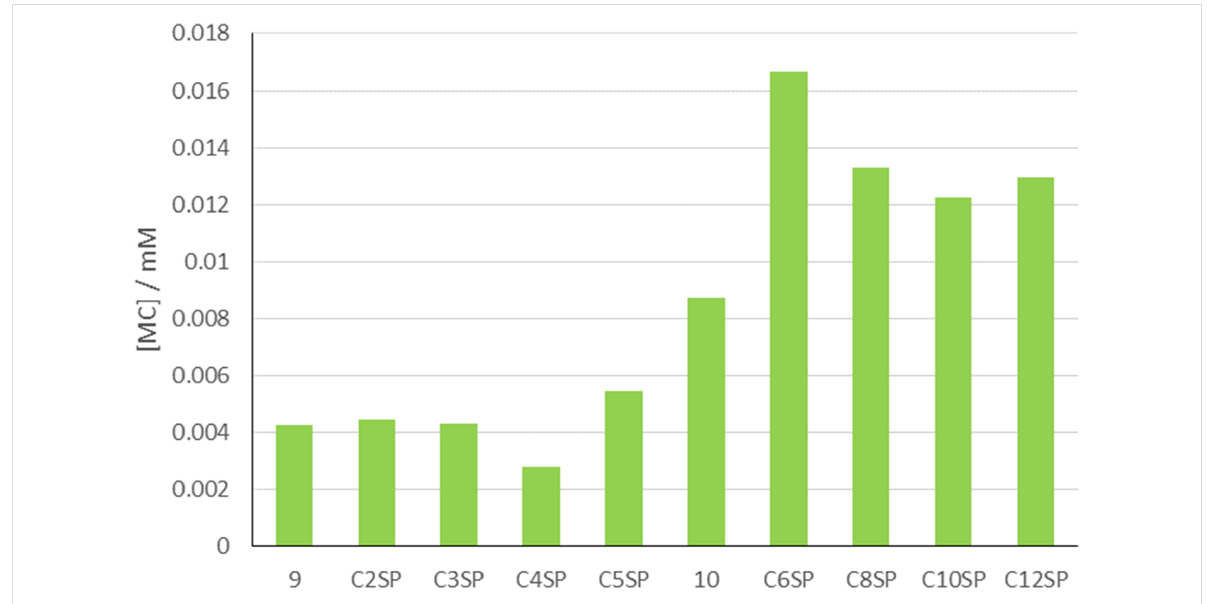
Figure 6: [MC] for spiropyrans C2SP – C12SP , 9 and 10 (0.1 mM) in CH 3 CN–H 2 O (99.9% v/v). Samples were kept in darkness for 18 h then analysed by UV–vis spectroscopy. Values for MC absorbance intensity were converted into [MC] using appropriate ε values.